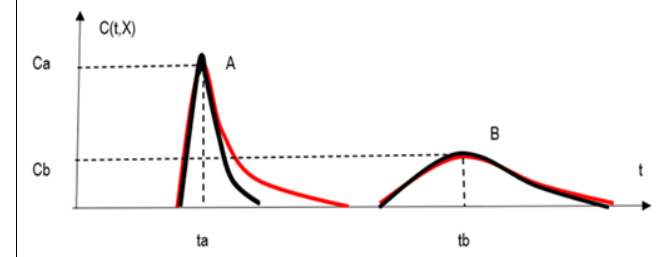
Figure 5: Decreasing bias over time of sequential Fickian tracer curves in the